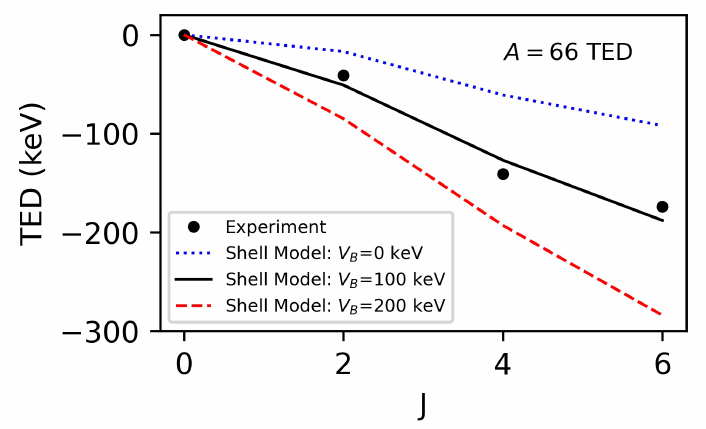
Figure 5. Experimental and shell-model TED for the A = 66, T = 1 isobaric triplet. The black line shows the full shell-model calculation, including a single isotensor J = 0 INC matrix element of V B = + 100 keV in all orbitals in the valence space. The other lines show the shell-model results using different strengths of the INC parameter, V B . See text for details. The calculations presented are based on the approach of Ref. [18]. The error bars on the data points are smaller than the data